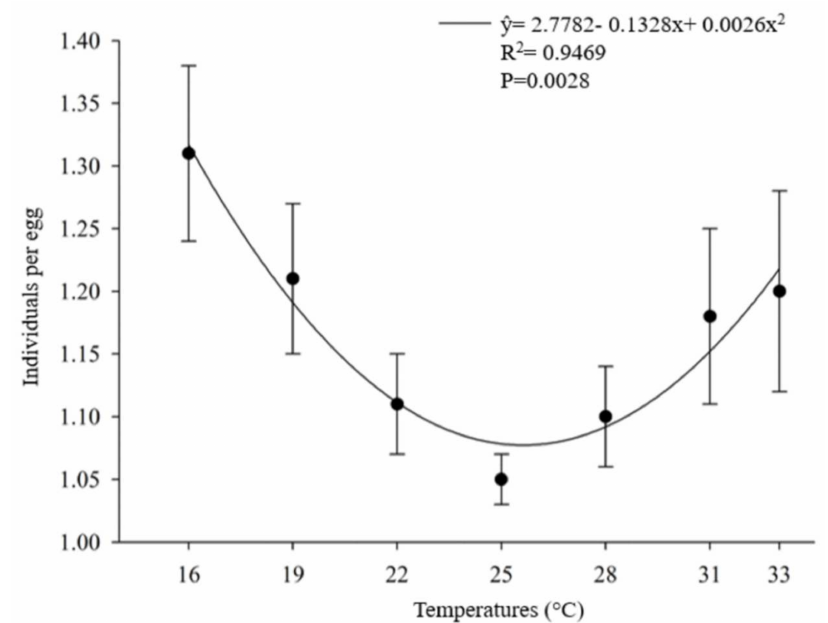
Figure 3. Number of parasitoids emerged per host egg parasitized (%) (mean ± EP) of Telenomus podisi in Euschistus heros eggs at different